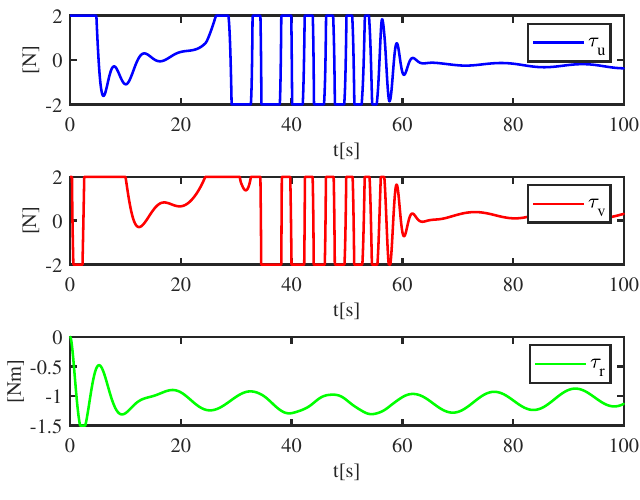
Figure 6. Unknown function and estimation.